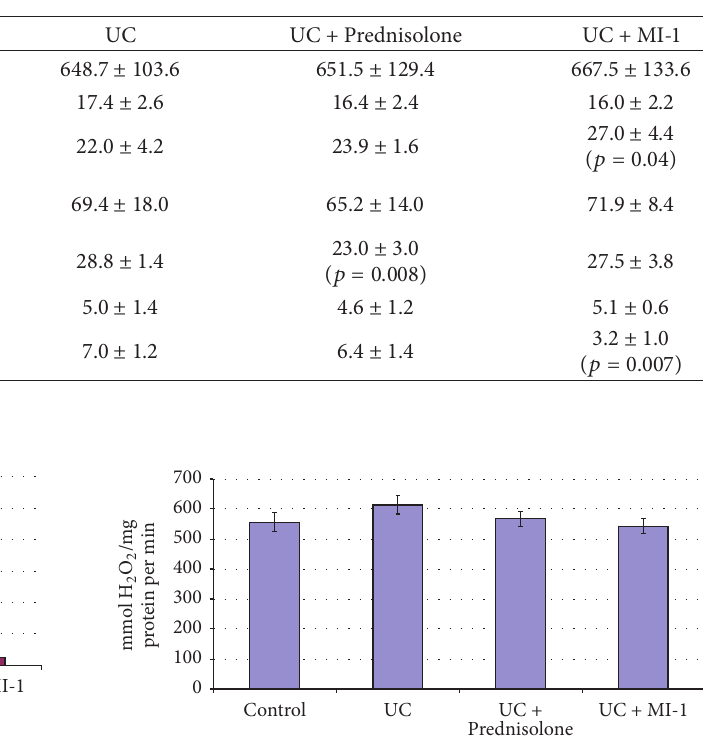
Table 1: Morphometric parameters of colon mucosa for rats experiencing UC and treated with Prednisolone and MI-1. Mean ± SD, 𝑛 = 10 ∗ .